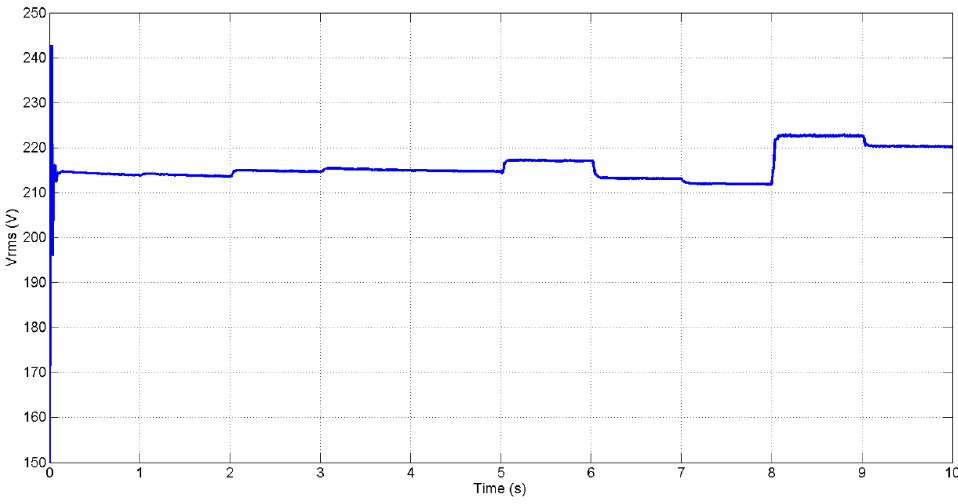
Figure 11. The terminal voltage fluctuations of the power unit.